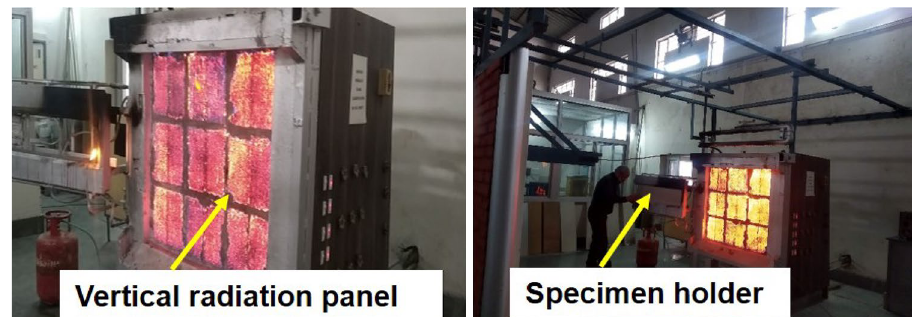
Figure 4. Surface spread of flame of products apparatus in accordance with BS 476 part